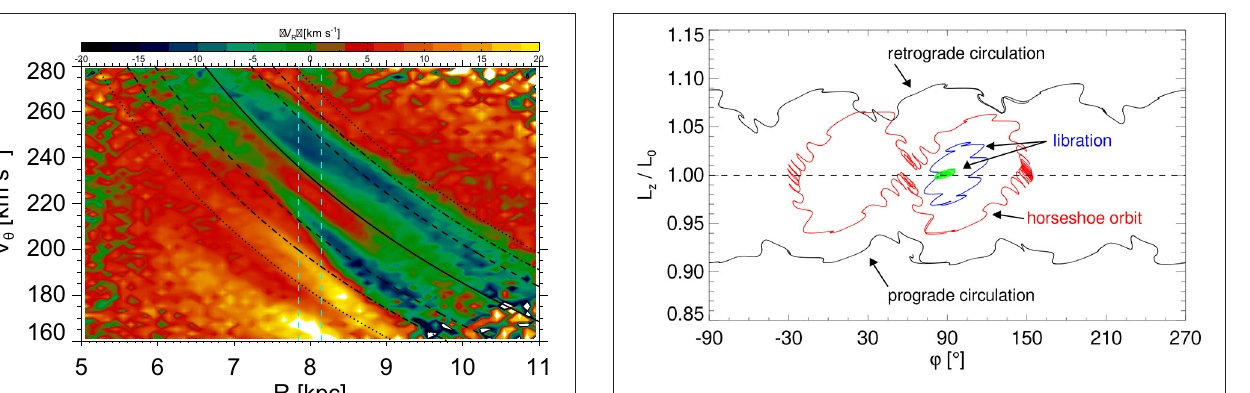
L z evaluated for the stable fixed points of the Hamiltonian, given by (cid:127) p R 2 , with R CR dependent on the value of (cid:127) p that CR is considered. Figure 10 shows another representation of the dependence of the solar orbit on the value of (cid:127) p , but in this case, for a wider interval of the (cid:127) p –values. The averaged (red) and minimal/maximal variations (black) of the solar orbit radius show that the amplitude of the radial motion is amplified inside a resonance region, indicated by the vertical dashed lines in the figure. The (cid:127) p interval where the Sun’s orbit is in corotation with the spiral pattern is ∼ 25 − 29 km s − 1 kpc − 1 . The corotation zone is surrounded by the layers where the motion of the Sun is chaotic, that is indicated by the scattered dots in Figure 10